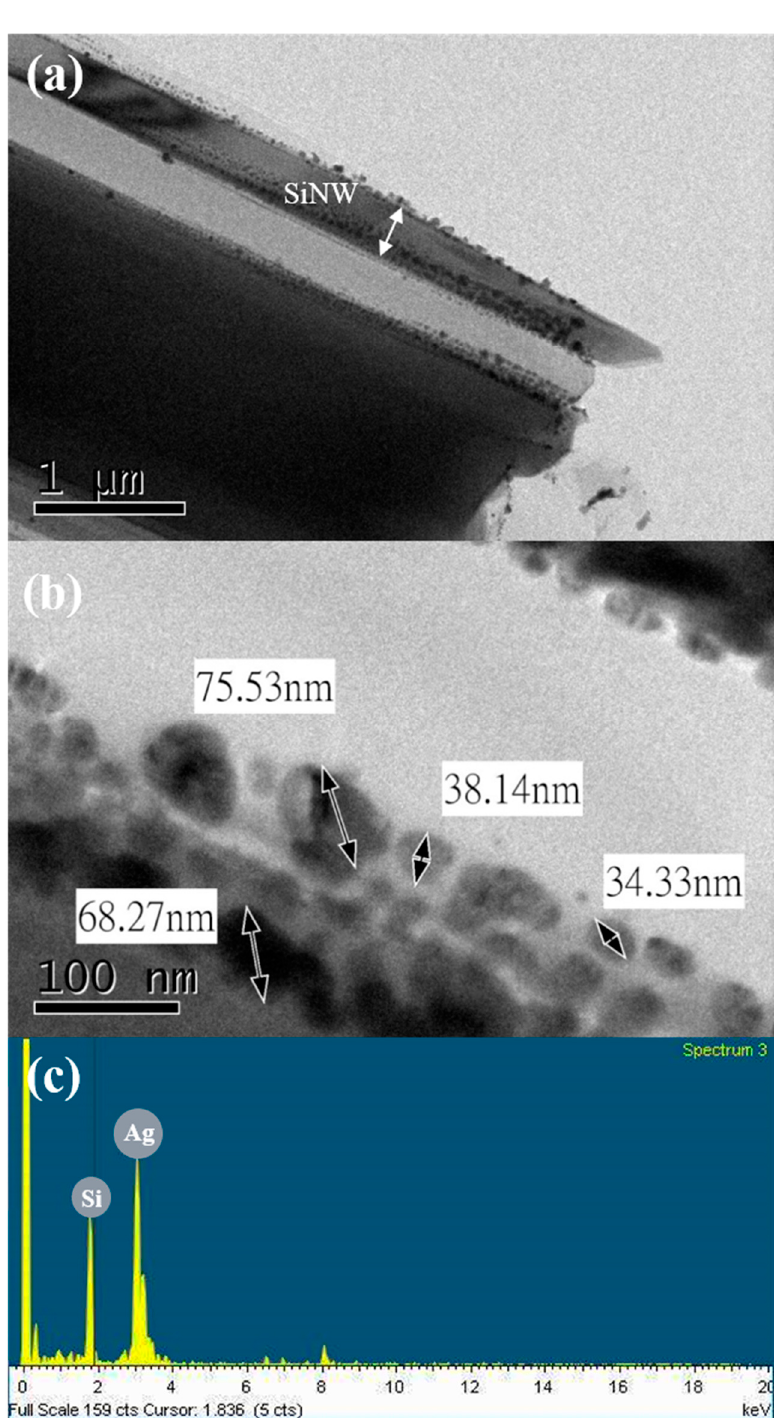
Figure 3. ( a ) TEM images of the SiNWs deposited with AgNPs, ( b ) the diameters of AgNPs dis- tributed in a wide range from 30 to 75 nm, and ( c ) EDS analysis of the SiNWs deposited with AgNPs. The XRD patterns of the unmodified SiNW arrays and the SiNW arrays deposited with AgNPs are shown in Figure 4. The modified SiNW arrays had diffraction peaks at 38.3°, 44.4°, 64.6°, and 77.5° and exhibited the following crystalline peaks of Ag, respec-